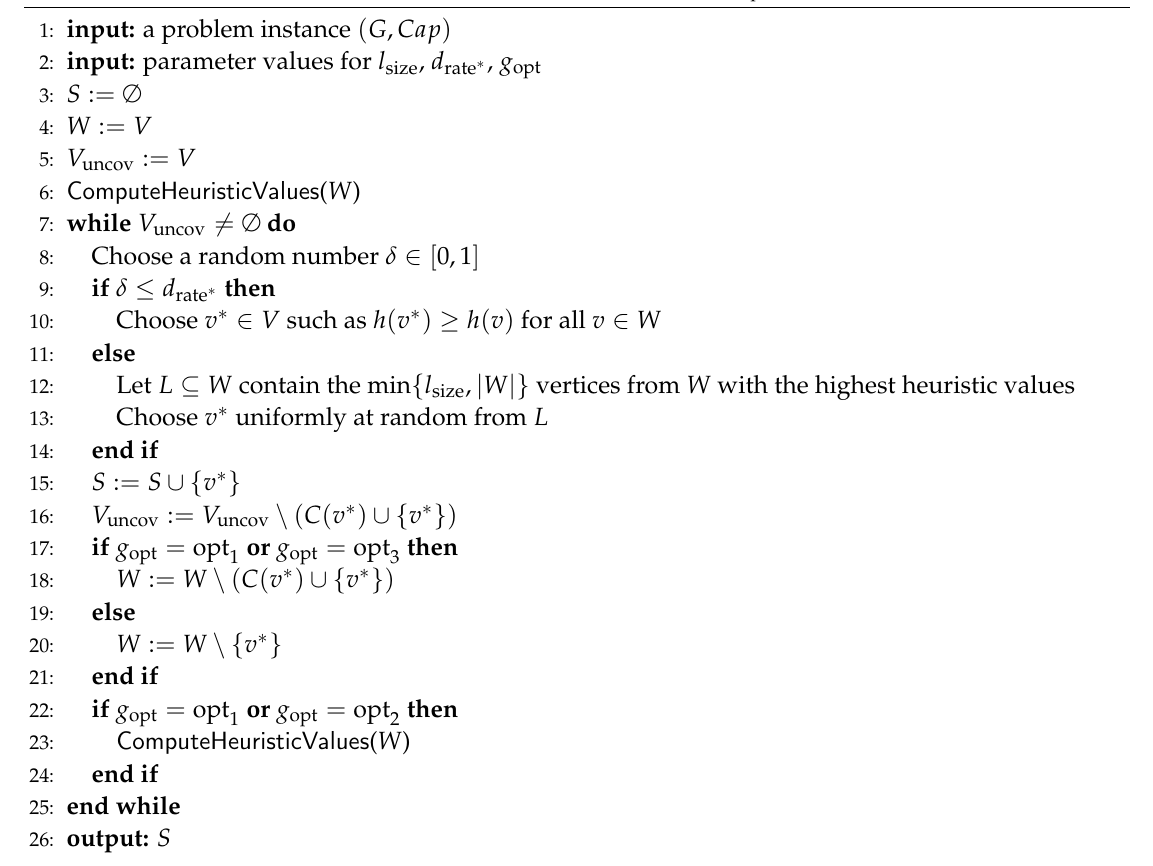
Algorithm 2 Function ProbabilisticSolutionGeneration ( d rate ∗ , l size , g opt